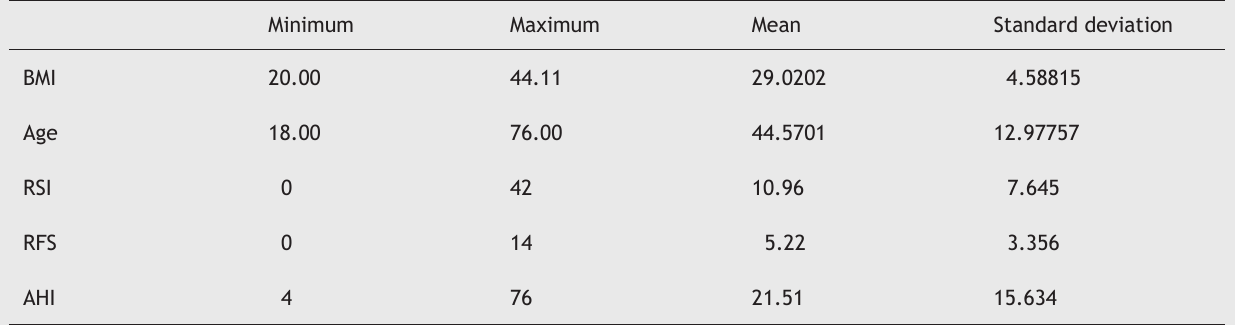
Table 1 Description of continuous